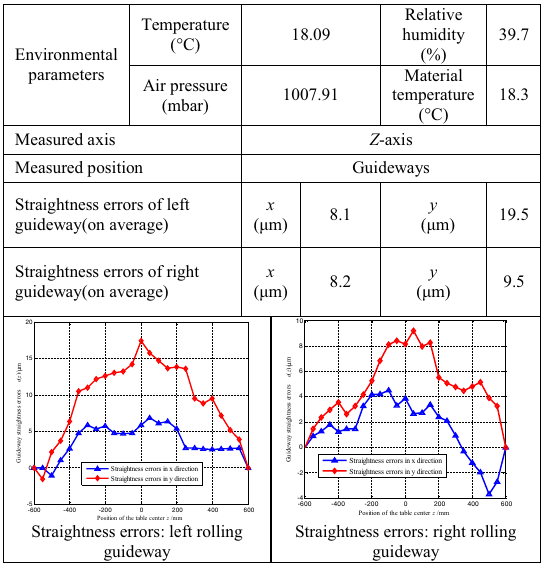
Table 4 Straightness errors of the left and the right rolling guideways Environmental parameters